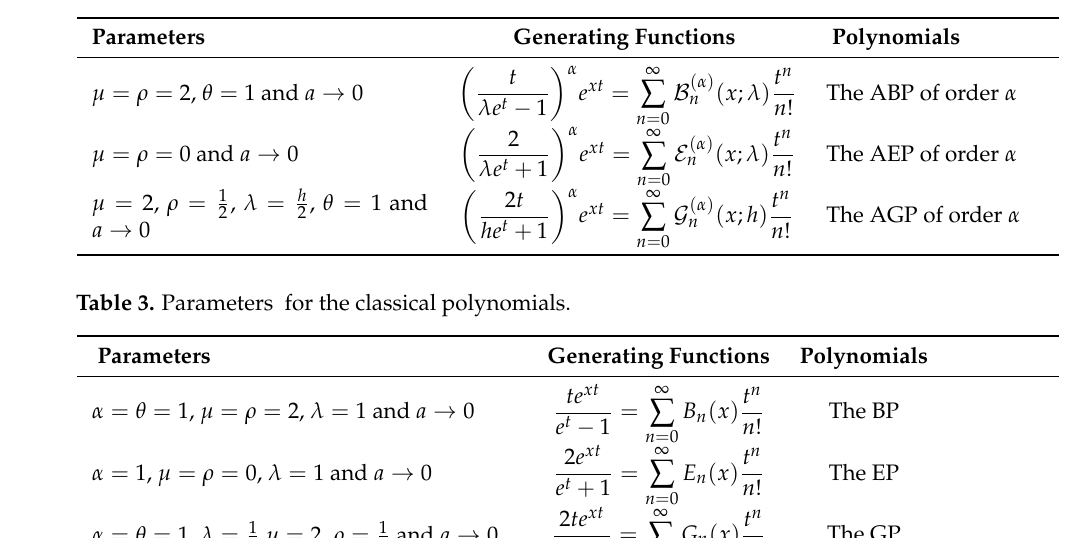
Table 2. Parameters for the Apostol type polynomials of order α .